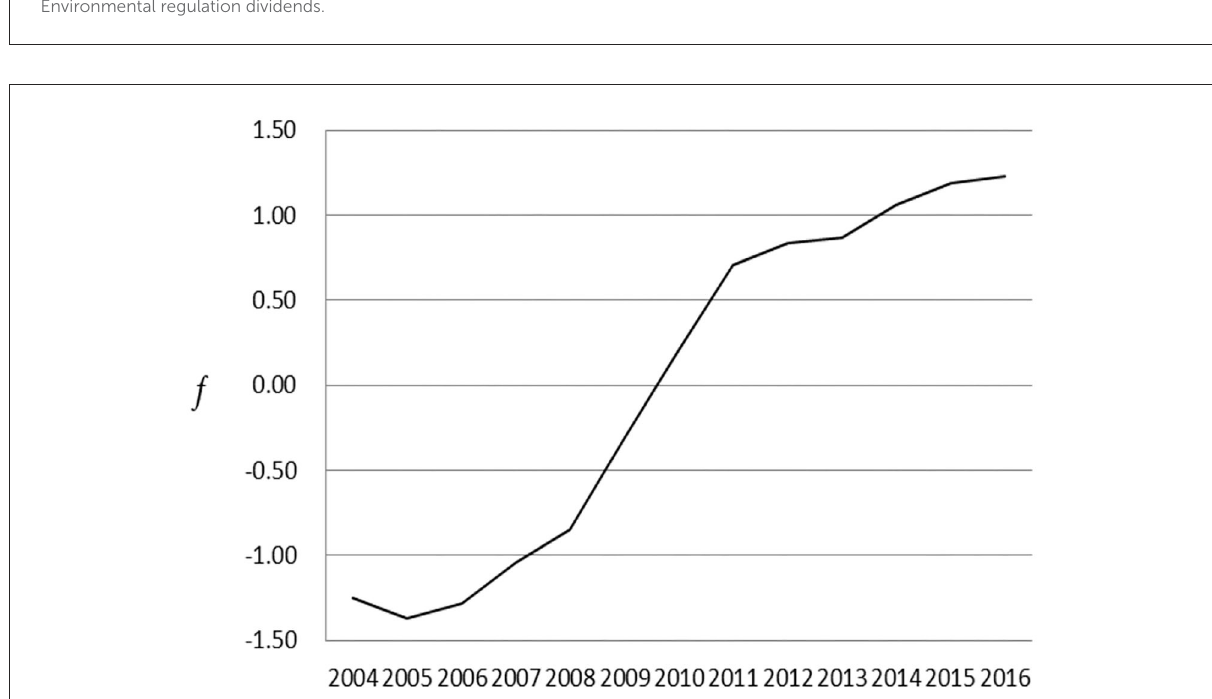
FIGURE2 Common factor